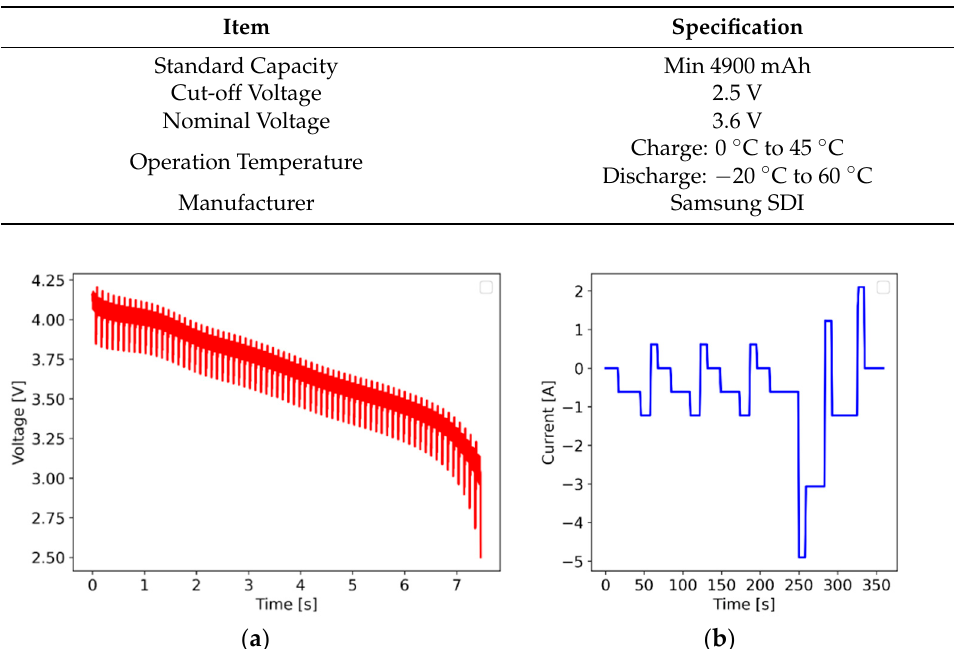
Figure 5. Battery experimental platform. Table 2. Specification of Samsung SDI INR 21700-50E.